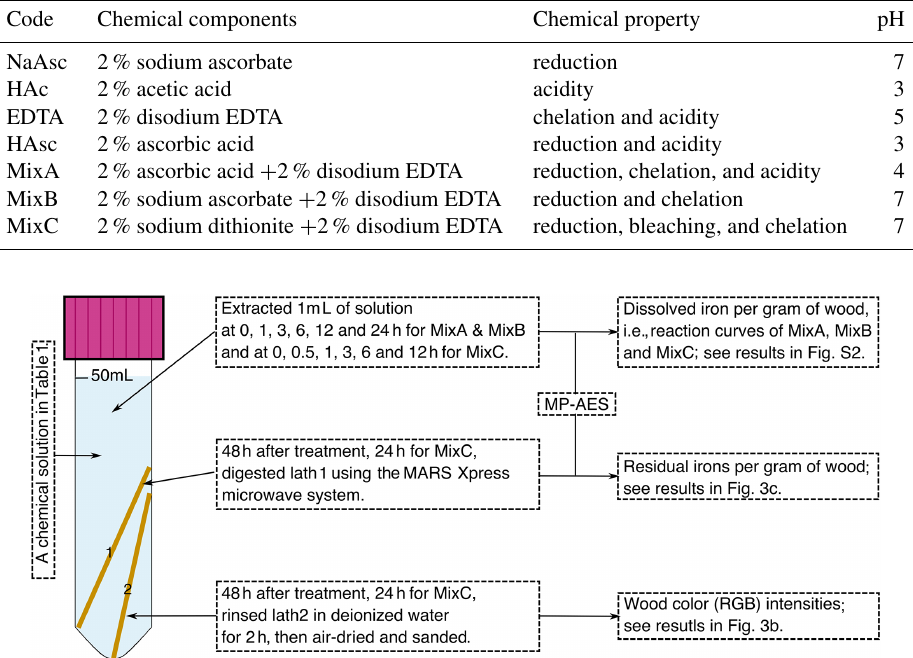
Table 1. Basic chemical properties of the seven chemical solutions. All solutions were diluted using deionized water with no trace of Fe concentration. Concentrations are in v/v for HAc and in w/v for other solutions. EDTA: ethylenediaminetetraacetic acid. Values of pH were estimated using pH test papers.